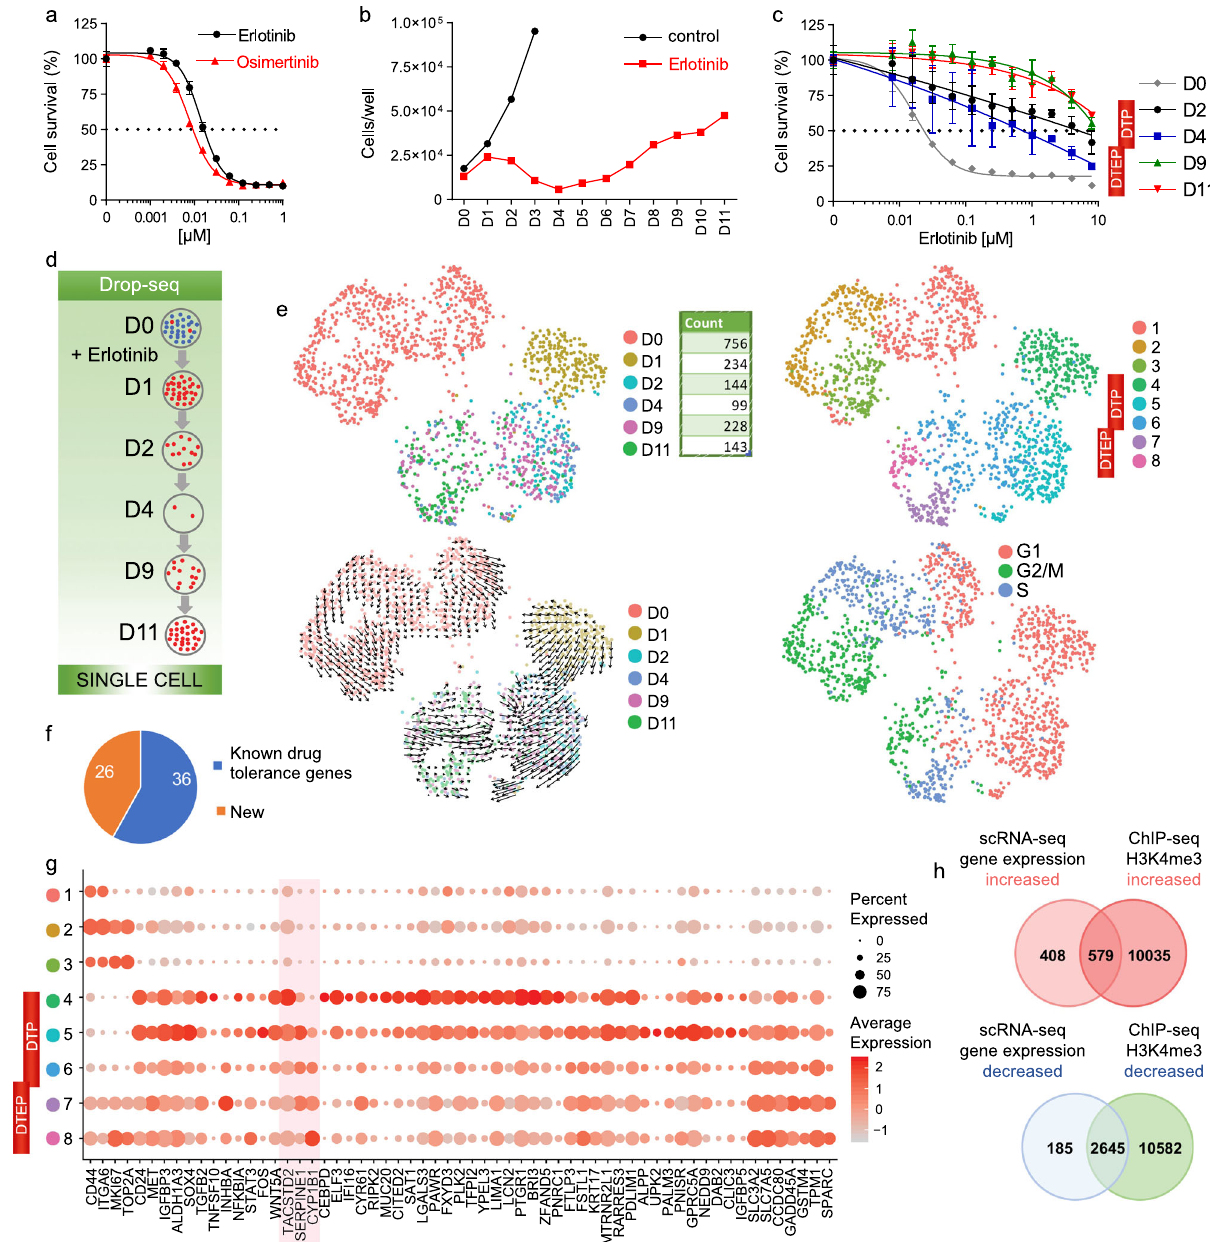
Fig. 1 Drop-seq recapitulates diversity of drug-tolerant states. a Dose response of PC9 cells to erlotinib and osimertinib at day 3 of treatment. Cell counting was performed using Hoechst. Mean ± standard deviation (SD) for n = 3 replicate wells are shown. b Growth curve of PC9 cells treated with erlotinib (2 µ M) during 11 days (D0 – D11), and growth curve of PC9 cells without addition of erlotinib during 3 days (D1 – D3). Cell counting was performed using hemocytometer, and data represents mean values for n = 2 replicate wells. c Dose response to erlotinib, describing PC9 cells (D0), and the DTPs and DTEPs generated from the original PC9 cells by treating in 2 µ M erlotinib for respective number of days (D2, D4, D9, and D11). D0, D2, D4, D9, and D11 PC9 cells were treated with erlotinib dilution series for 3 days, after which cells were counted using Hoechst, mean ± SD for n = 3 replicate wells. d Schematic for the set of consecutive samples for single-cell RNA-seq. D0 are untreated cells, and D1 through D11 is the duration of treatment with the drug. Drop-seq was done on cells at Day 0 (D0), Day 1 (D1), Day 2 (D2), Day 4 (D4), Day 9 (D9), and Day 11 (D11) of the treatments. e UMAP representation of PC9 cells colored by days of treatment (left top panel), clusters (right top panel), days of treatment with Velocyto projection (left bottom panel), or the cell cycle phase positioning of each cell (right bottom panel). f Literature search with the top markers of tolerant states identi fi ed by Drop- seq using the terms [GENE NAME] + chemoresistance, [GENE NAME] + drug, and [GENE NAME] + resistance. g Dot plot of transcript expression for top cluster markers. The color of each dot represents the average expression level from low (gray) to high (red), and the size of each dot represents the percentage of the cells expressing the gene. Markers selected for functional validation are highlighted in red. h Overlap of genes with increased and decreased expression level and H3K4me3 level in PC9 cells treated with erlotinib for 11 days versus untreated.